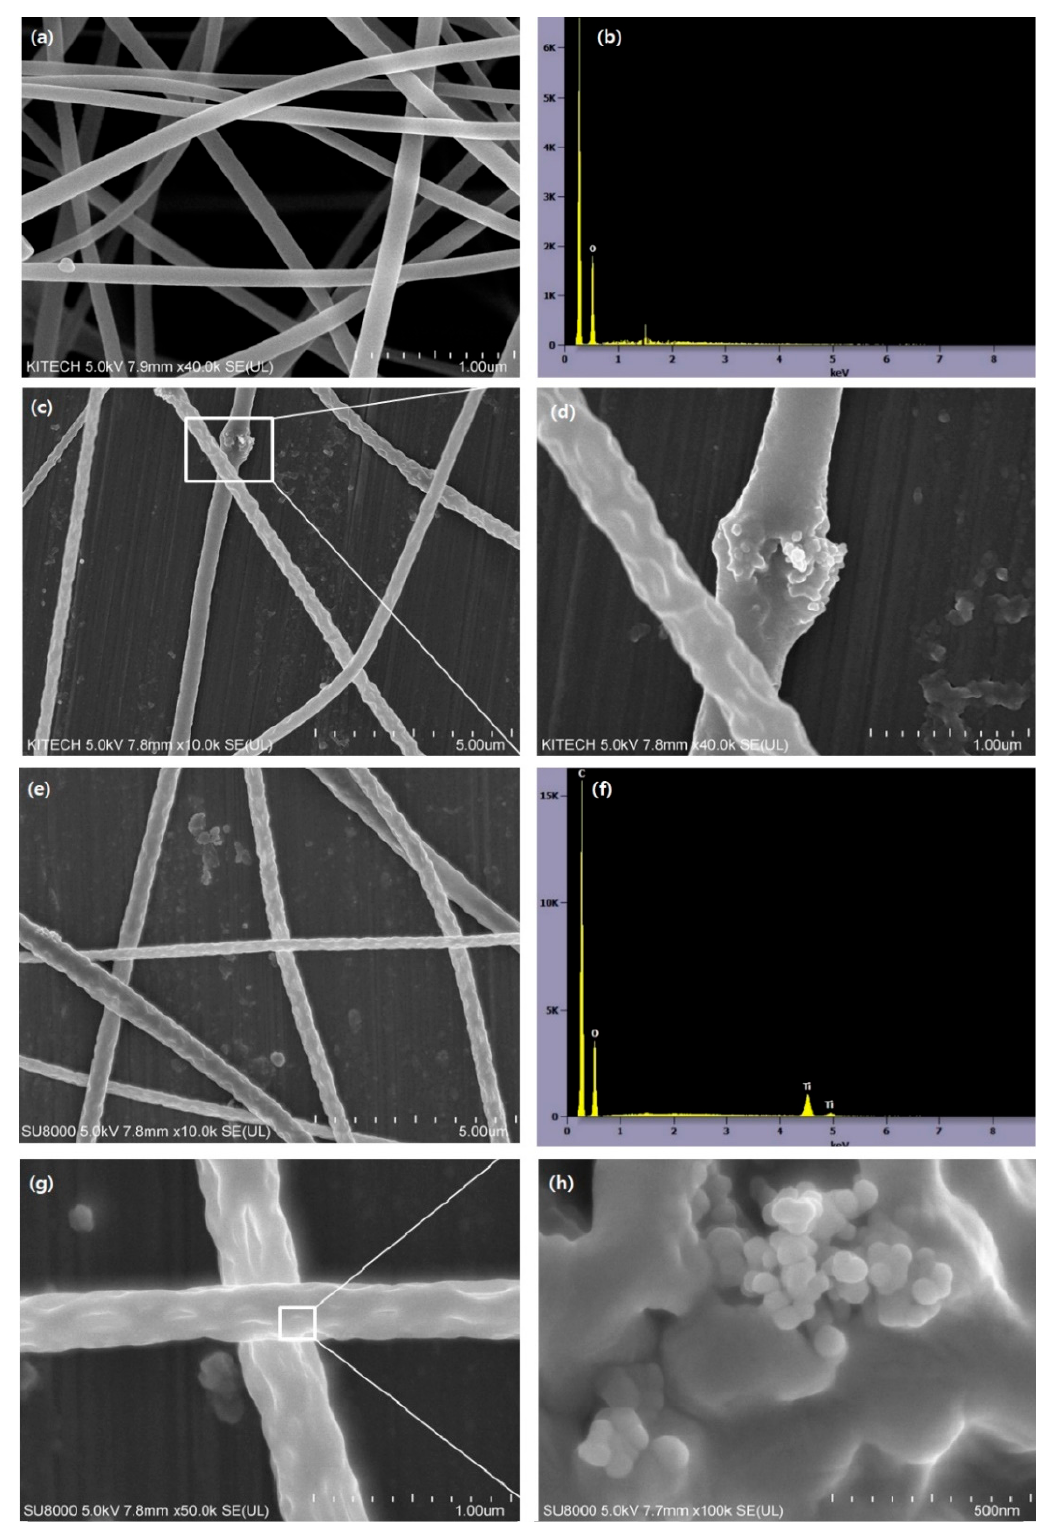
Figure 2. SEM images of ( a ) untreated CA nanofibers, ( b ) EDX analysis of untreated CA nanofibers, ( c ) 5 wt% TiO 2 -CA nanofibers, ( d ) the enlarged image of the square on the left, ( e ) 10 wt% TiO 2 -CA nanofibers, ( f ) EDX analysis of 10 wt% TiO 2 -CA, ( g ) the surface morphology of 10 wt% TiO 2 -CA nanofibers, and ( h ) the enlarged image of the square on the left.